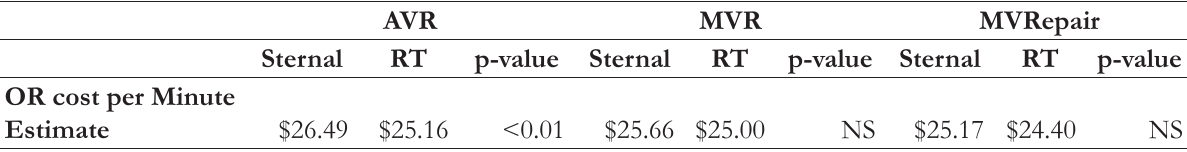
P-value shown compares Sternal vs. RT for the specific valvular procedure. LS means adjusted for region, teaching status, urban status, and number of beds. OR cost per minute was modeled using generalized linear models with a gamma distribution and log link due to the inherent distribution of cost